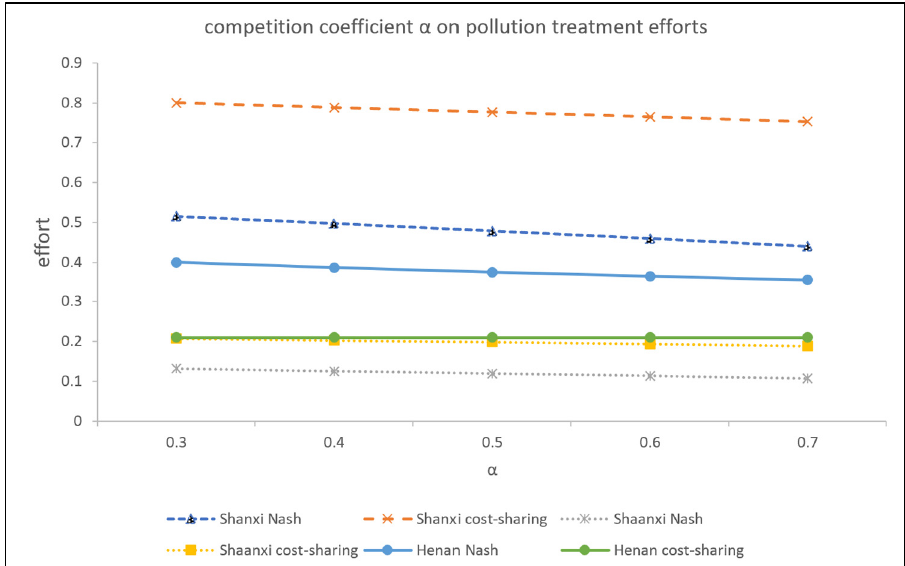
Figure 5. The effects on pollution treatment efforts.